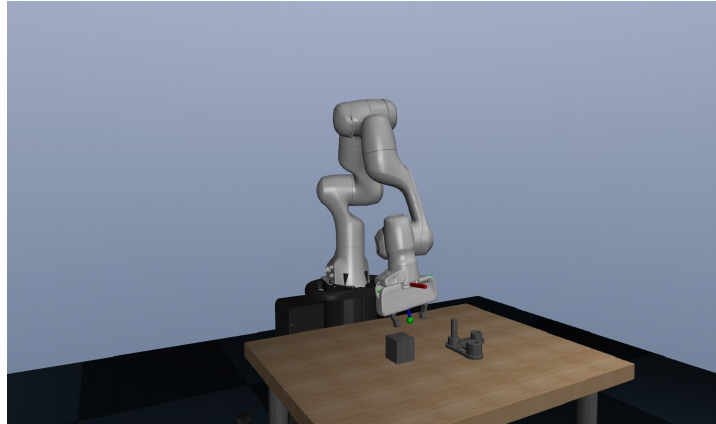
Figure 4. Franka EMIKA panda robot employed in the target grasping task in the MuJoCo